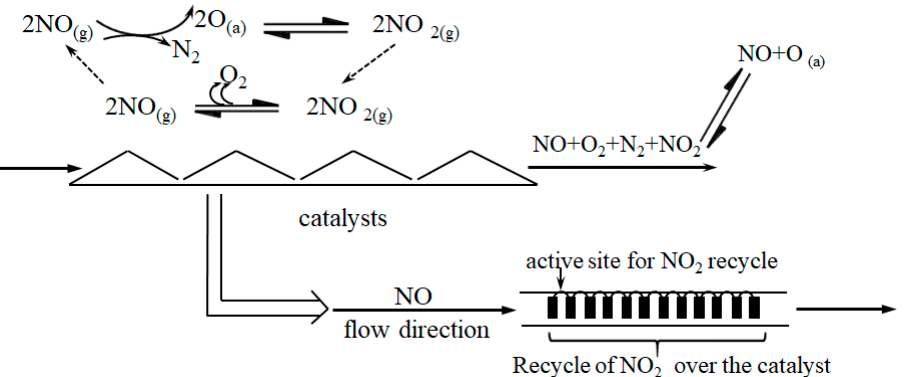
Figure 4. The mechanism of cyclic decomposition of NO on perovskite-like oxides with NO 2 as an intermediate species .